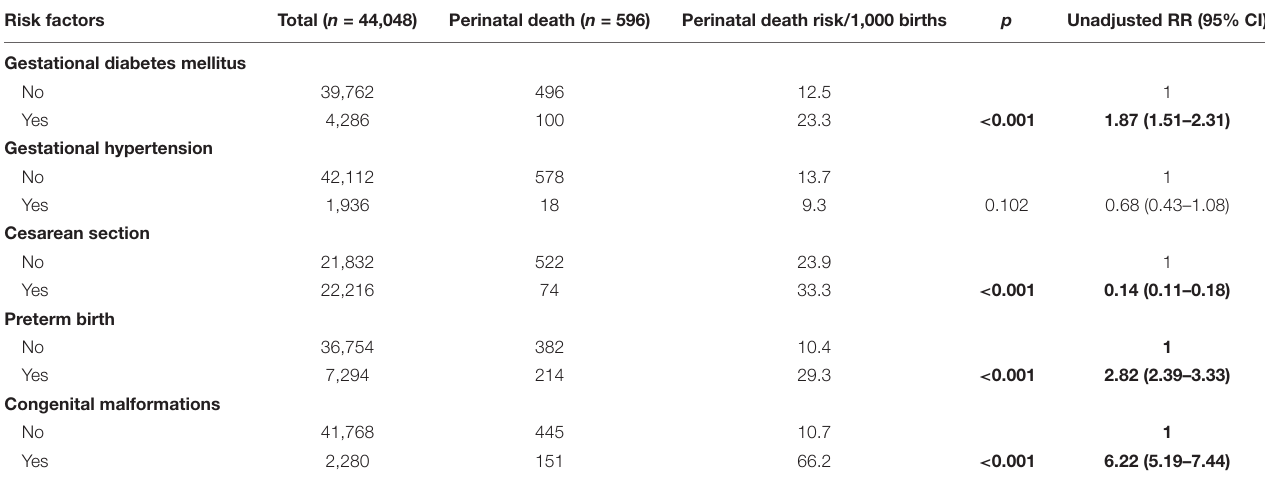
TABLE 4 | Complications and outcomes of pregnancy and unadjusted relative risk (RR) for perinatal death among 44,048 pregnant women. Risk